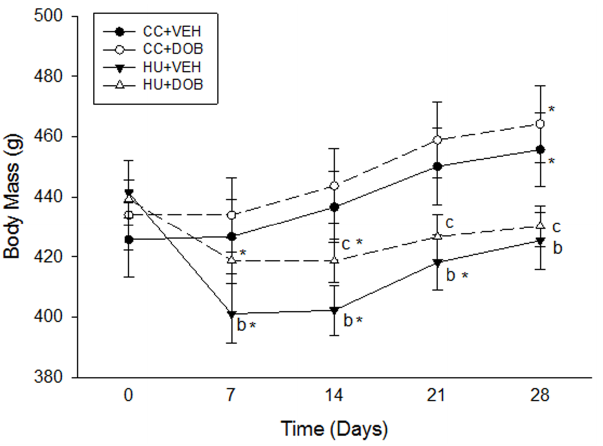
Figure 1. Effects of dobutamine (DOB) or vehicle (VEH) administration during hindlimb unloading (HU) or ambulatory cage activity (CC) on body mass. * vs. Day 0 (p # 0.05); a HU + DOB vs. HU + VEH (p # 0.05); b HU + VEH vs. CC + VEH (p # 0.05); c HU + DOB vs. CC + DOB (p # 0.05).